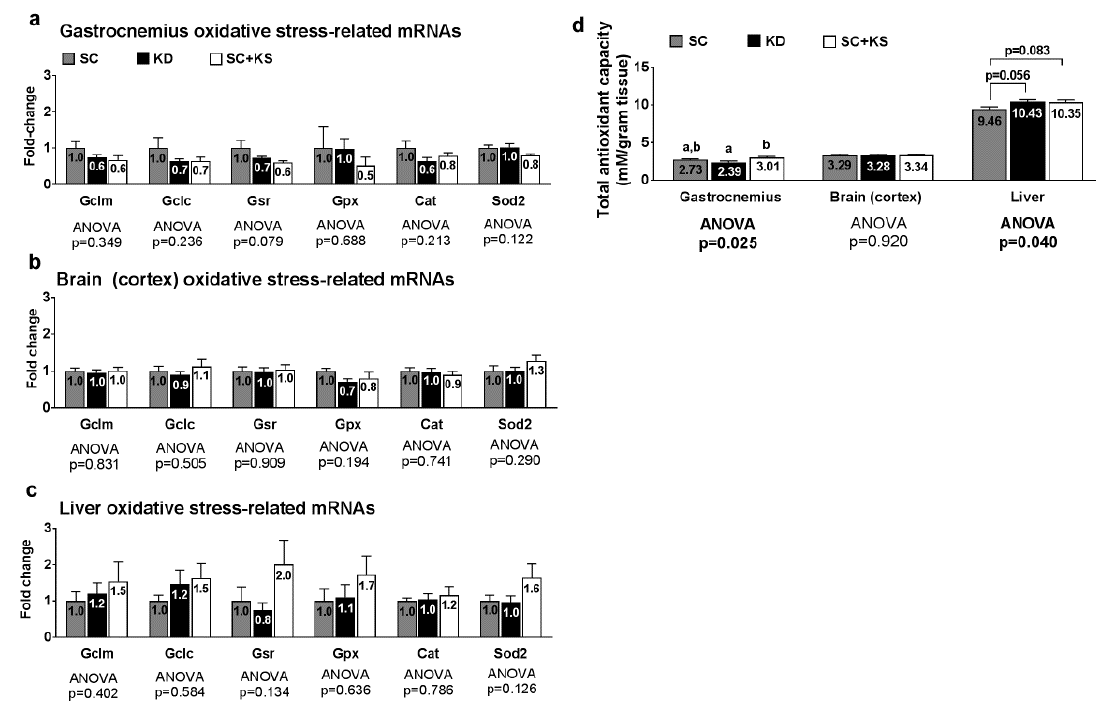
Figure 2. Oxidative stress and endogenous antioxidant-related markers in 1 week-fed rats. Legend: Oxidative stress and endogenous antioxidant related mRNAs are shown for gastrocnemius panel ( a ); brain panel ( b ); and liver panel ( c ). Tissue total antioxidant capacity levels are presented in panel ( d ). Fold-change for each mRNA are expressed relative to the SC group, all bars are presented as mean ± standard error values ( n = 10 per group), group means are indicated within each bar, ANOVA p -values are presented below data, and different lettering in panel D (“a” versus “b”) indicates significant between-group differences whereas shared lettering (“a” as well as “b” or “a, b”) indicates lack of significant between-group differences. Abbreviations: Gclm, glutamate-cysteine ligase modulatory subunit; Gclc, glutamate-cysteine ligase catalytic subunit; Gsr, glutathione reductase; Gpx1, glutathione peroxidase; Cat, catalase; Sod2, supoeroxide dismutase 2; SC, standard chow-fed rats; KD, ketogenic diet-fed rats; SC + KS, standard chow-fed rats with supplemental sodium beta-hydroxybutyrate.